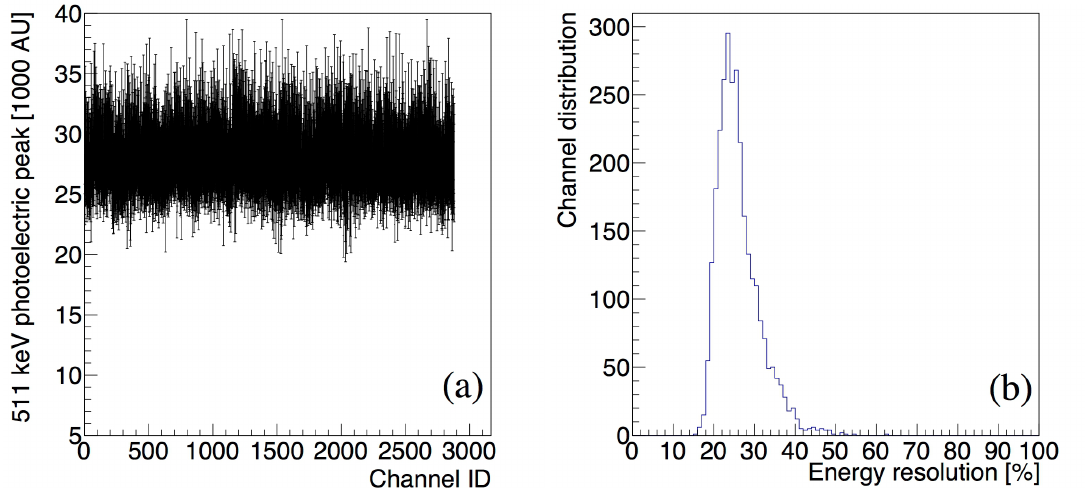
Figure 7. System calibration: position (ph pos ) ( a ) and energy resolution (FWHM/ph pos ) ( b ) of the 511 keV photoelectric peak measured during a 22 Na calibration run in the 2880